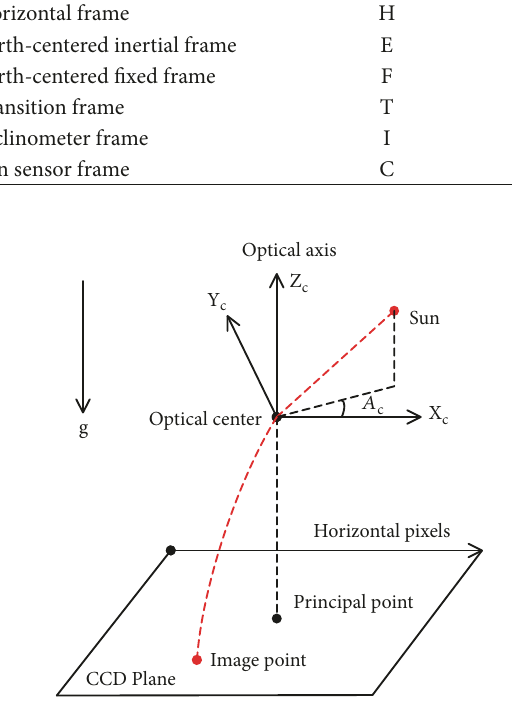
Figure 2: Schematic of sun azimuth measurement.